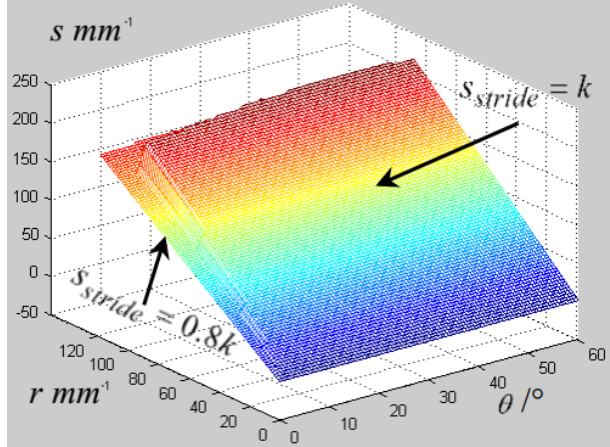
Figure 11. Enhanced stride length varying with the twisting angle θ and the lateral distance r in the continuous periodic gait.